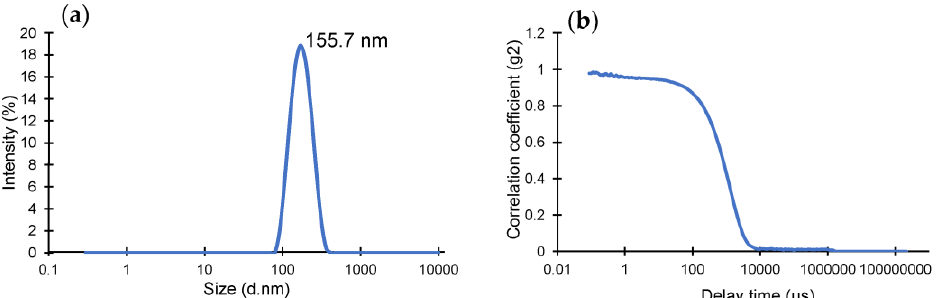
Figure 1. ( a ) Hydrodynamic size distribution of cTnI-specific epitope-imprinted nanoMIPs. ( b ) Cor- relation fit of DLS data confirming the quality of the measurement.